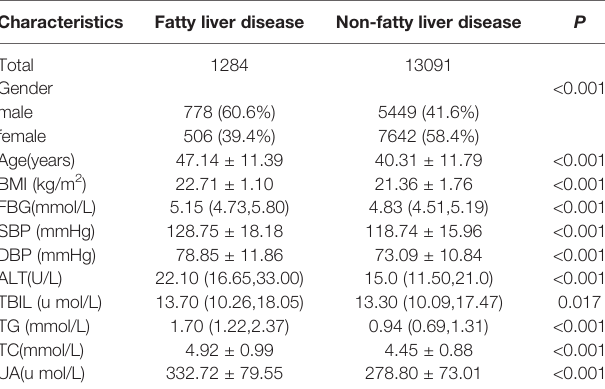
TABLE 5 | Comparison of baseline data of the non-FLD group and the non- obese FLD group among the non-obese physical examinees in 2016. Characteristics